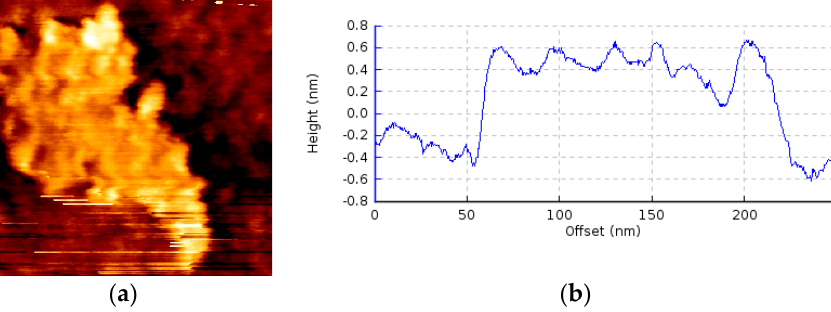
Figure 5. Simulations of the phase shifter mode of the transmission line with Rg = 3000 Ω / for all cases: ( a ) Amplitude variation; ( b ) Phase variation.